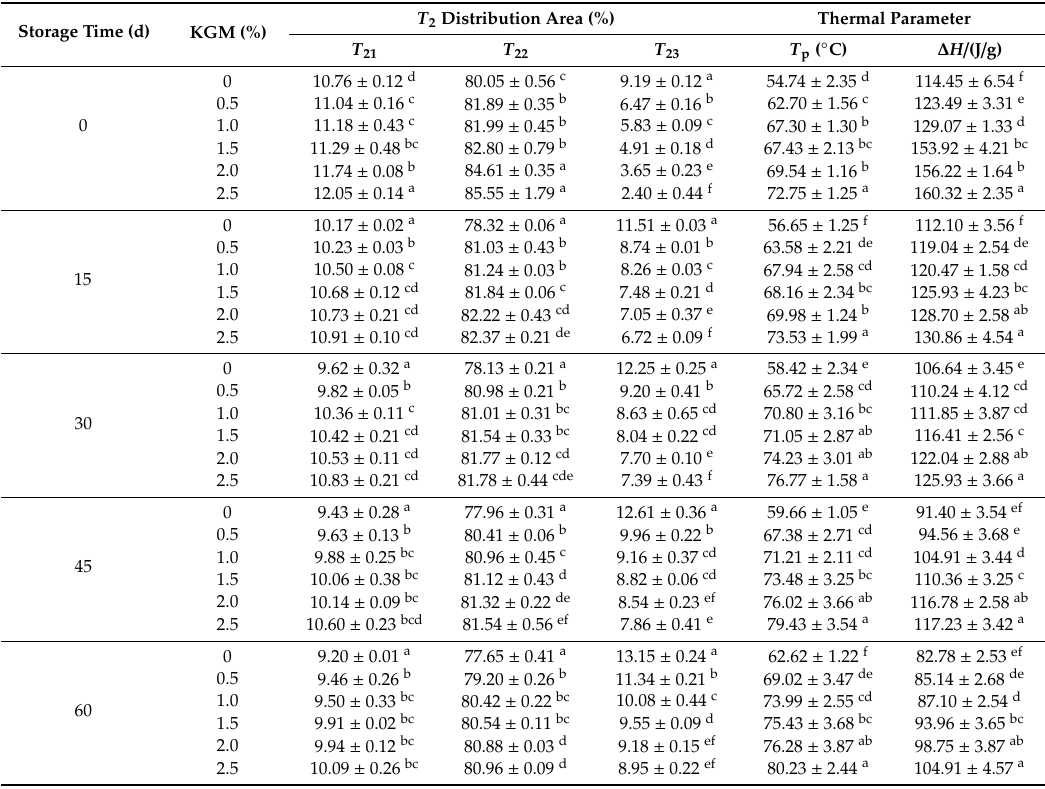
Table 2. E ff ect of di ff erent proportions of KGM added on T2 distribution and the thermal parameter of frozen